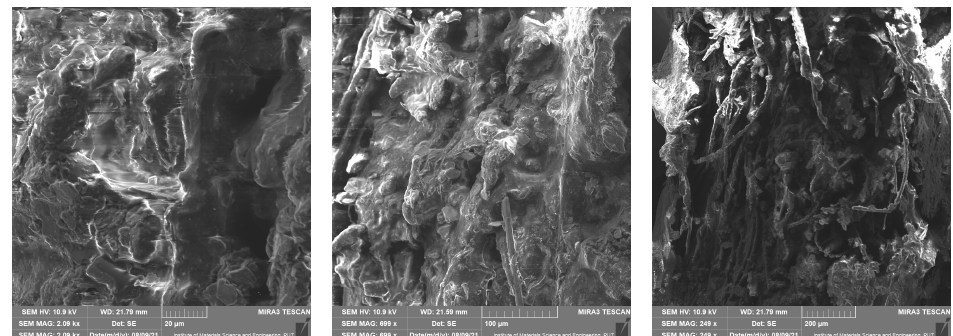
Figure 7. SEM photos for material M3.